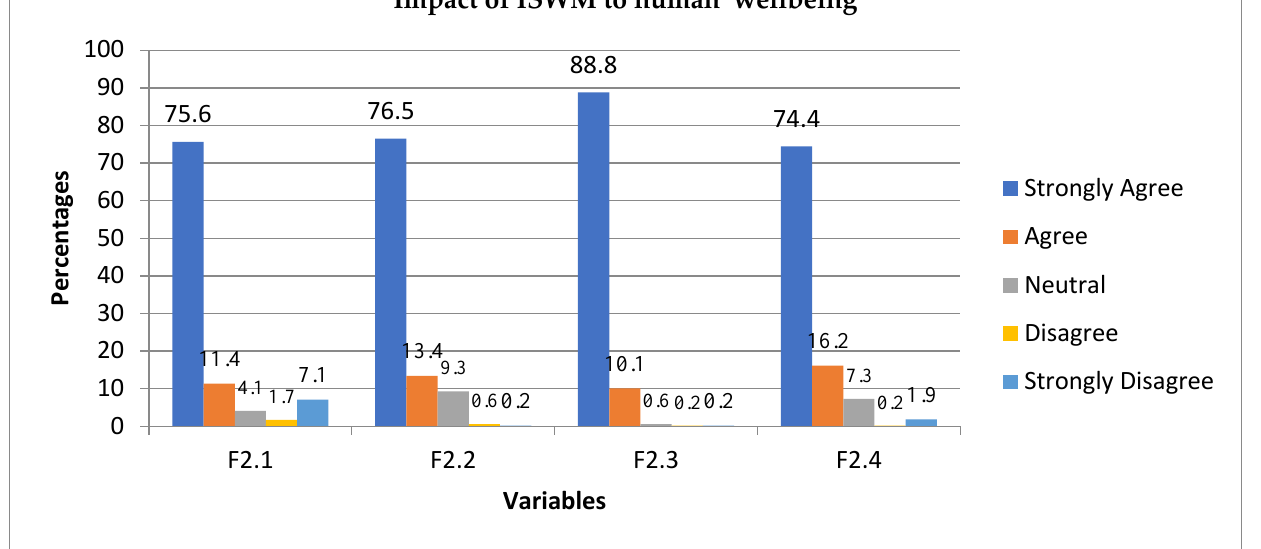
Figure 5. The illustration of how respondents perceive the impact of indigenous systems of waste management on human wellbeing. Variables are questions: F2.1 = Occurrence of infectious diseases, F2.2 = Rodents and mosquitoes, F2.3 = Effects on human beings, F2.4 = Ignorance.